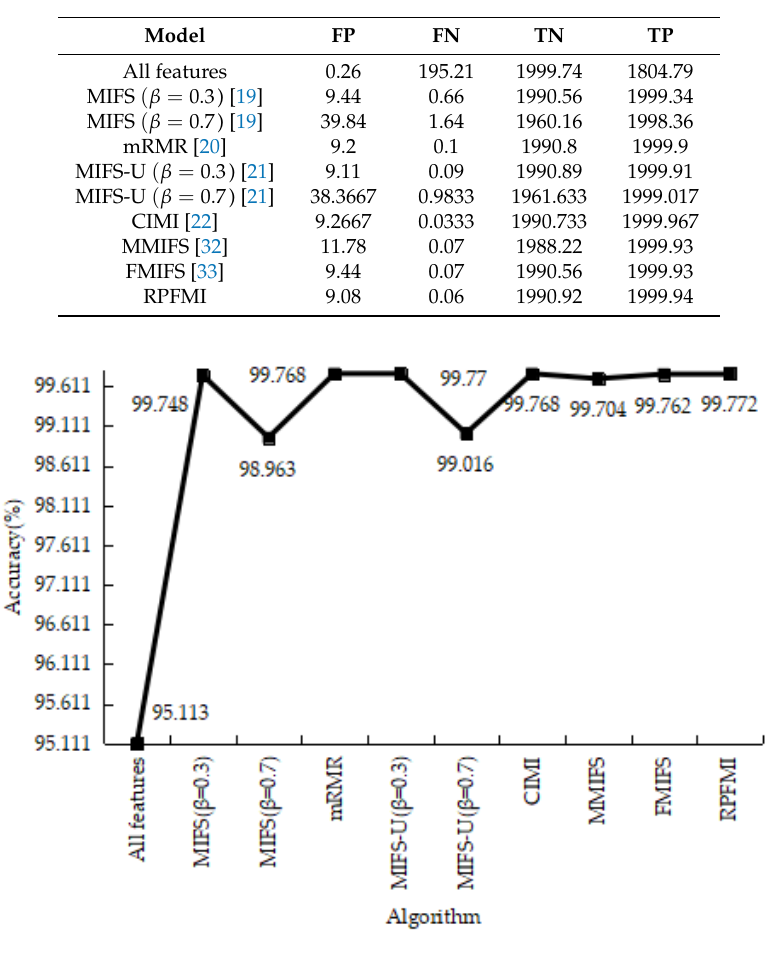
Figure 1. Accuracy on the DOS test data.